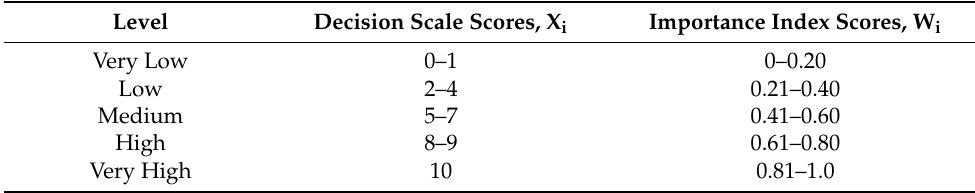
Table 1. Levels and scores of decision scale and importance